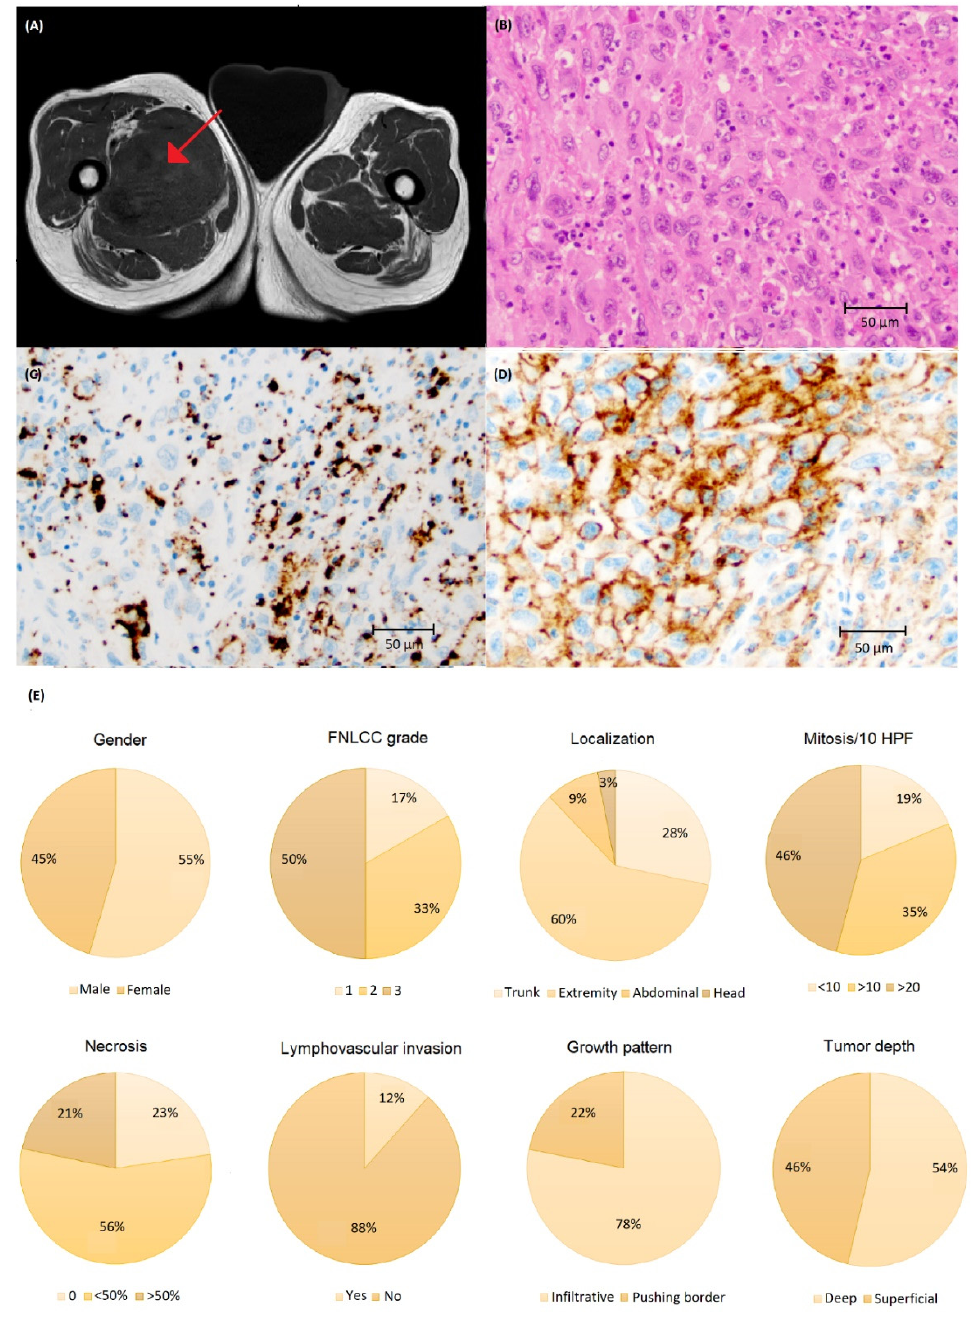
Figure 5. ( A ) Magnetic resonance imaging of undifferentiated pleomorphic sarcoma (UPS) in the thigh (arrow) and ( B ) histology of UPS stained with ( C ) SP142 and ( D ) SP263 assays at × 200 magnification showing a higher number of cells with PD-L1 immunoreactivity using the SP263 assay. ( E ) Clinical and tumor characteristics of the UPS